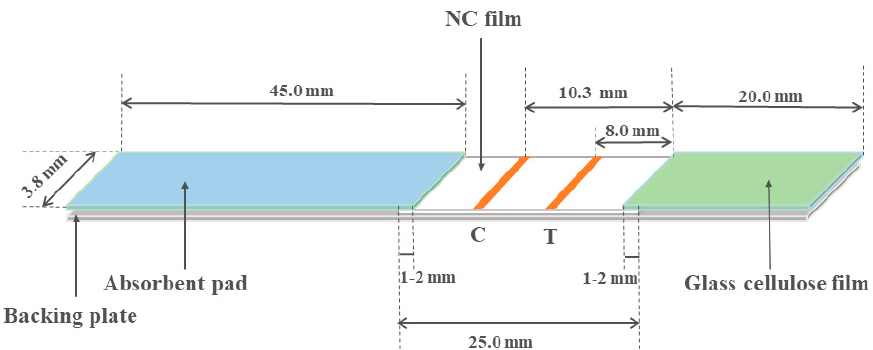
Figure 1. Time-resolved fluorescence immunochromatography (TRFIA)paper-based sensor assembly structure diagram.